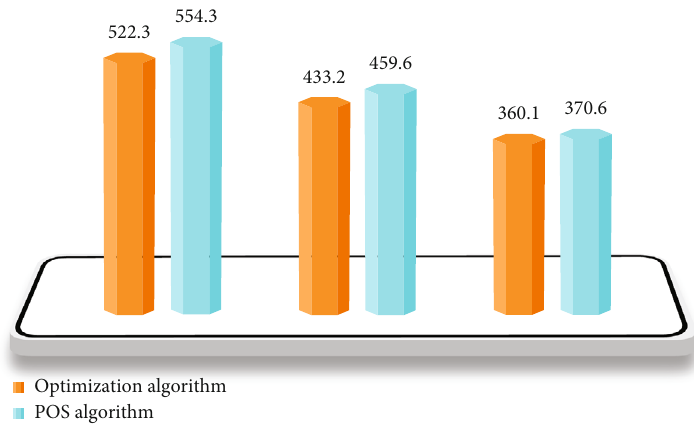
Figure 5: Average algebra comparison chart.